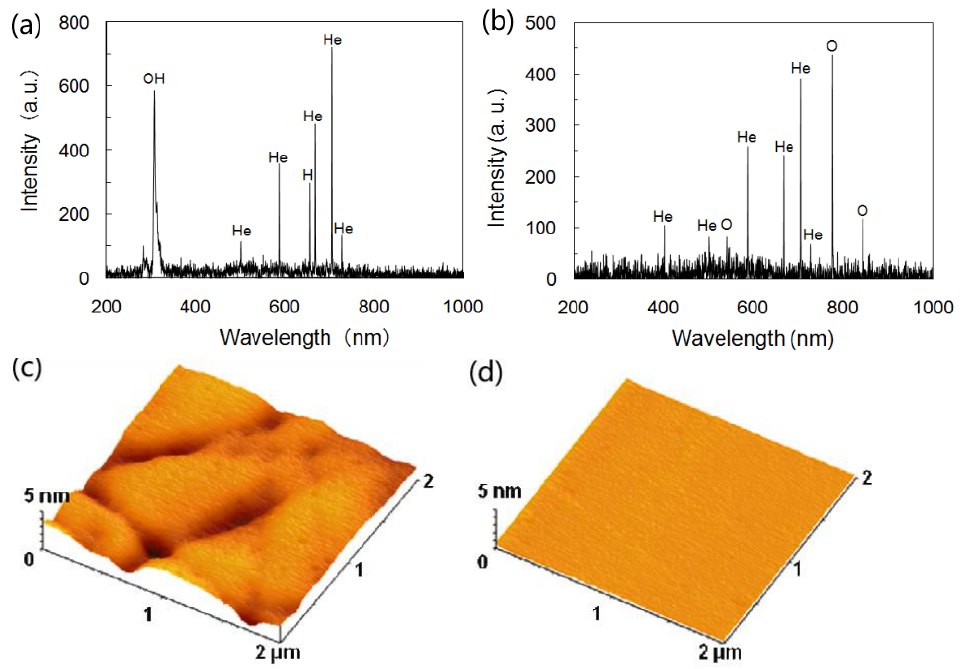
Figure 14. Emission spectra of the plasma: ( a ) water vapor plasma, ( b ) oxygen plasma; AFM images of 4H-SiC: ( c ) unprocessed surface at 0.495 nm rms, ( d ) surface after PAP at 0.060 nm rms [12].